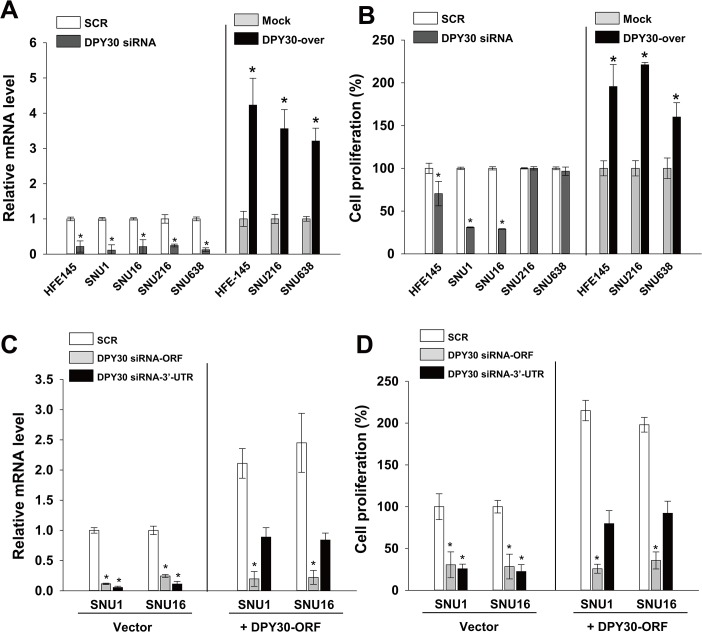
DPY30 regulated the proliferation of gastric cancer cells.(A) Real-time PCR was used to determine the efficiency of knockdown or overexpression of DPY30 in HFE145, SNU1, SNU16, SNU216 and SNU638 cells. Knockdown efficiency was determined after transfecting cells with 100 nM DPY30 siRNA targeting the ORF or scrambled siRNA (SCR). Overexpression efficiencies were determined in DPY30-overexpressing and mock cells. (B) Effect of DPY30 knockdown or overexpression on cell proliferation. A cell viability assay was used to measure cell proliferation in the presence of 1% FBS. For the DPY30 knockdown experiments, cell viability assays were performed five days after transfecting 100 nM DPY30 siRNA or SCR. After three days of culture, cell viability assays were performed on DPY30-over and mock cells. (C) Expression analysis of DPY30 after known-down or overexpression by siRNAs or DPY30 ORF respectively. The ORF-targeting or the 3’-UTR-targeting siRNA was used for the knock-down. (D) Exogenous DPY30-ORF rescued the inhibition of proliferation by the 3’-UTR-targeting DPY30 siRNA. Mock or DPY30-overexpressing cells were transduced with two kinds of DPY30 siRNA (3’-UTR-targeting or ORF-targeting), then cell viability assay was examined. Values are the means ± SDs of three independent experiments performed in triplicate. *, p < 0.01 (Student’s t test, versus SCR or Mock).